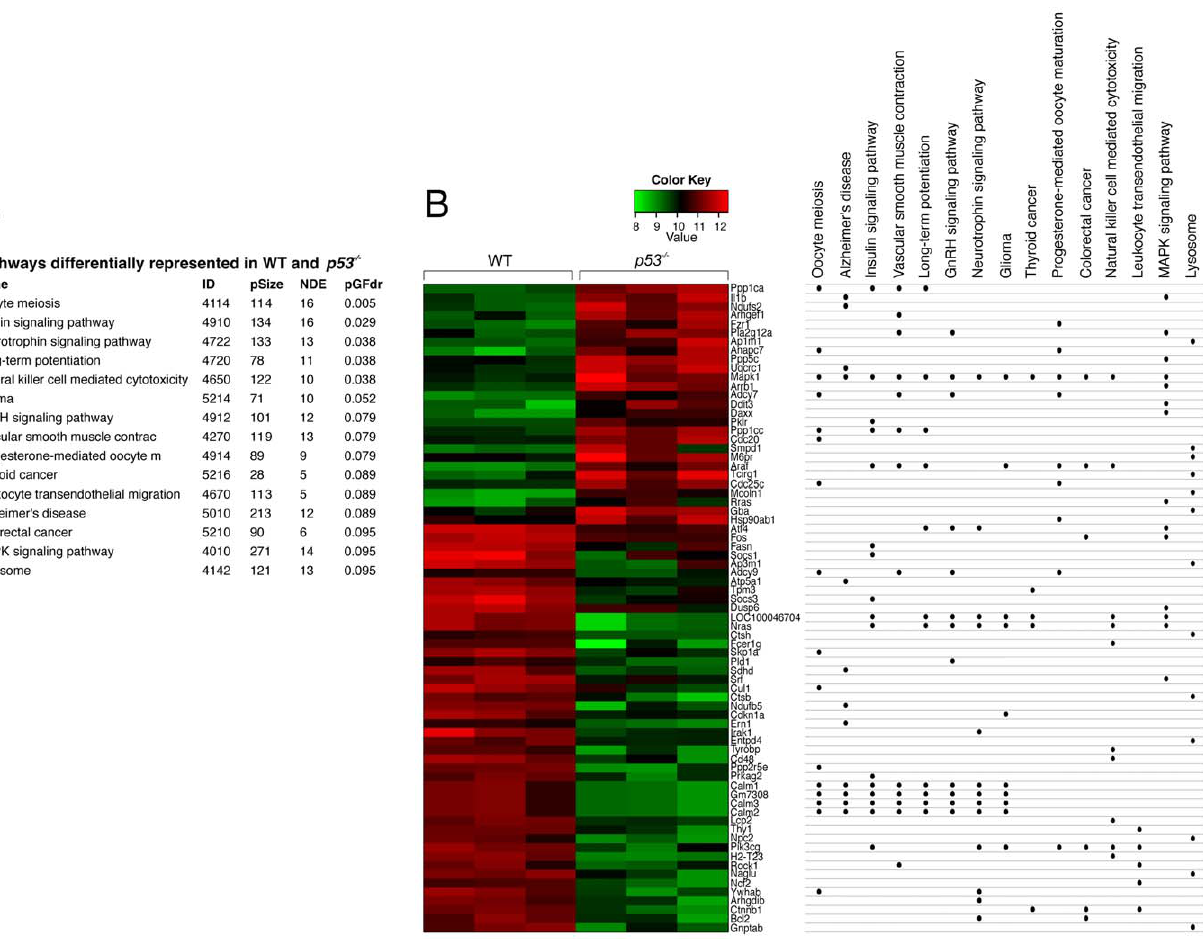
Figure 2. Pathway analysis of WT and p53 2 / 2 samples cultured in the presence of cytokine. (A) List of activated and inactivated pathways identified by a Signaling Pathway Impact Analysis (SPIA) of array results from WT and p53 2 / 2 samples. The ID is the KEGG ID, pSize indicates the number of genes in the KEGG pathway, NDE is the number of differentially expressed genes found within the pathway and pGFdr is the False Discovery pathways (FDR , 0.1). Significant pathways are shown. (B) The differentially expressed genes that account for the significant SPIA pathways (from Figure 2A) are depicted by the heatmap. To the right of the heatmap, the dots indicate the pathways to which each gene contributes and whether a gene is represented by several of the pathways.